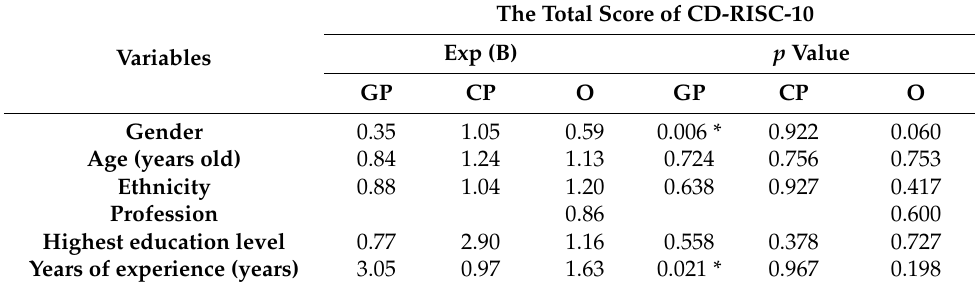
Table 8. Multinomial logistic regression for